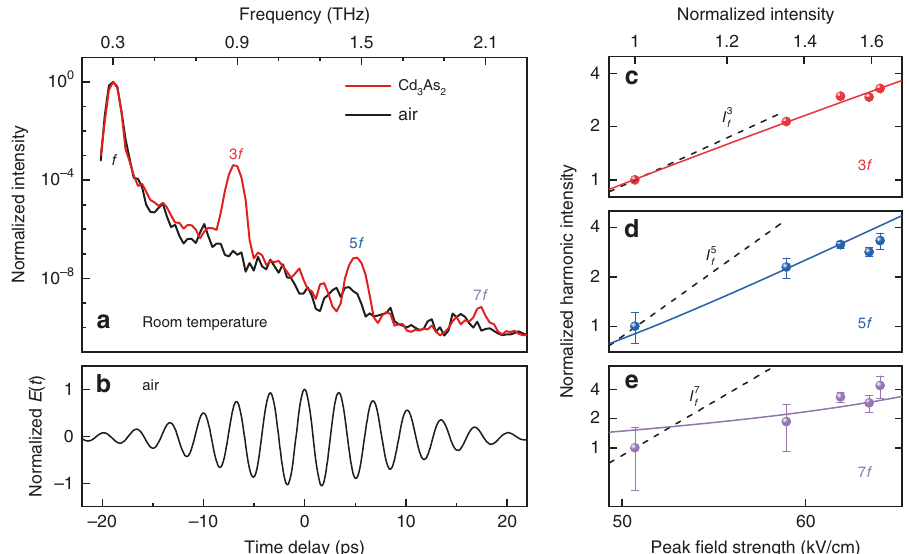
Fig. 3 High-harmonic generations in Cd 3 As 2 . a Room-temperature spectrum of high-harmonic generations in Cd 3 As 2 for b multicycle pump pulse of f = 0.3 THz, compared with air as a reference. Pump-intensity dependence of the c third-harmonic, d fi fth-harmonic and e seventh-harmonic generation (symbols) follows the power laws of I f 2.6±0.1 , I f 2.8±0.1 , and I f 2.8±0.7 , respectively. The dashed lines indicate the corresponding perturbative power laws, i.e., ∝ I 3 , I 5 , and I 7 . In c – e , the solid lines show the fi tted theoretical results corresponding to the relaxation time τ = 10 fs. The error bars indicate the noise level f f f at the corresponding data